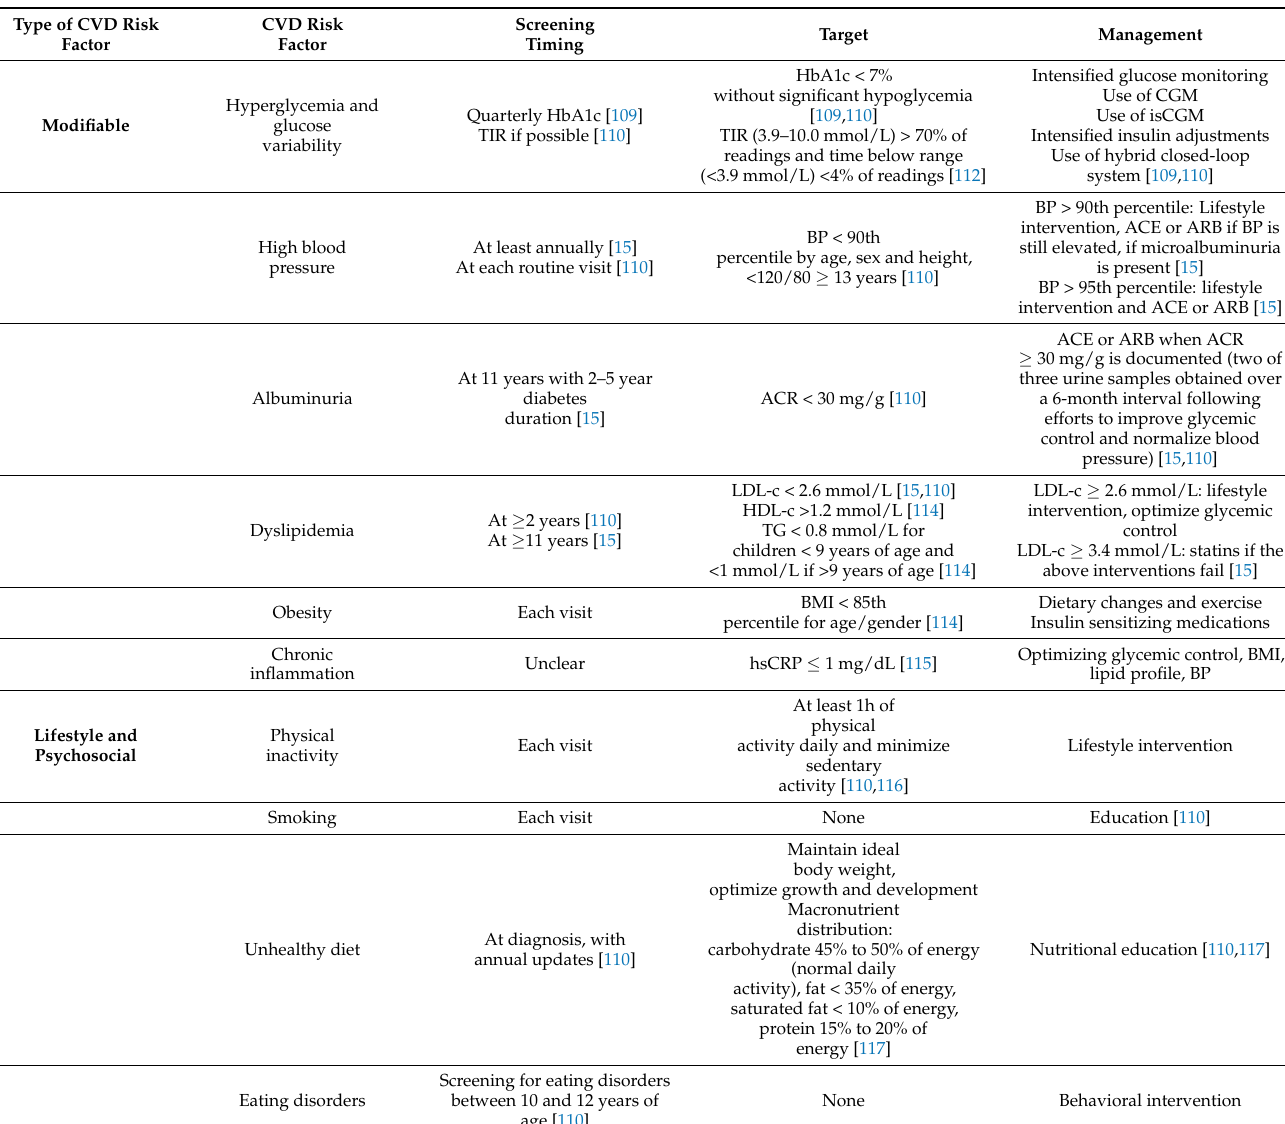
Table 2. Current clinical guidelines for early screening and management of cardiovascular risk factors in children and adolescents with type 1